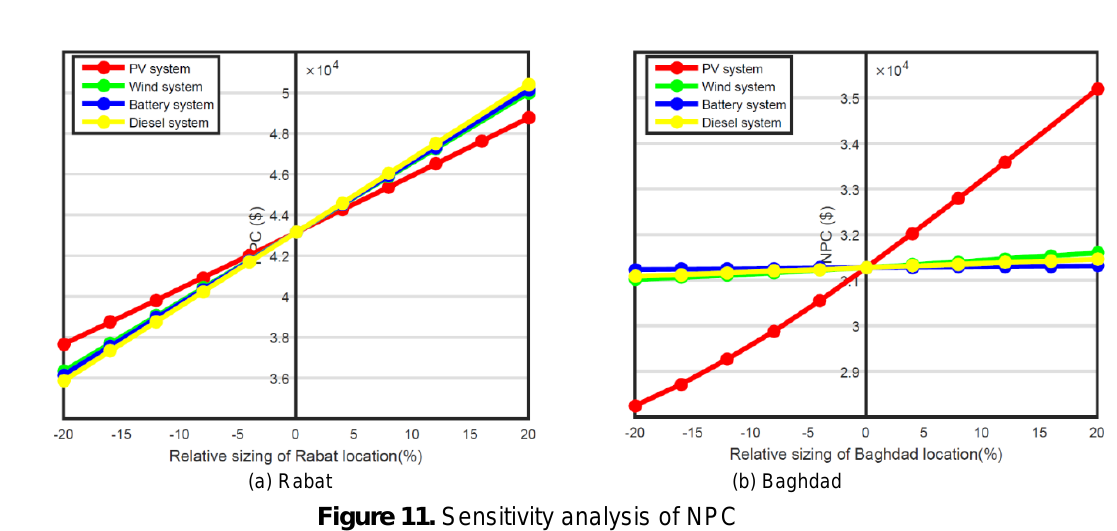
Figure 11. Sensitivity analysis of NPC